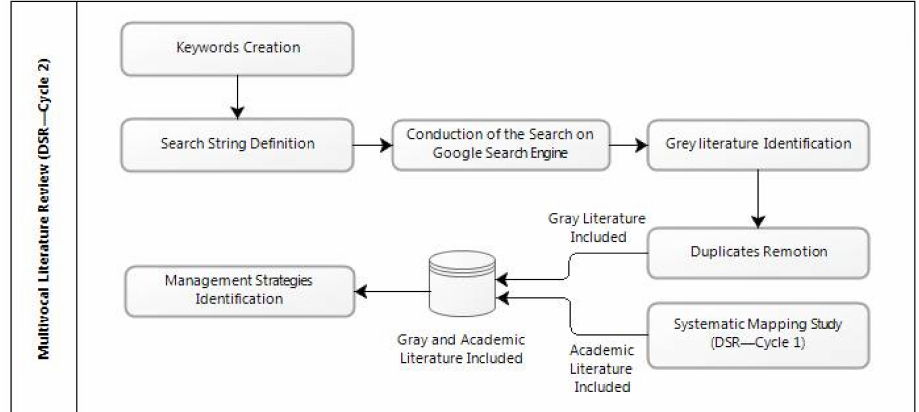
Figure 2. Multivocal Literature Review steps.